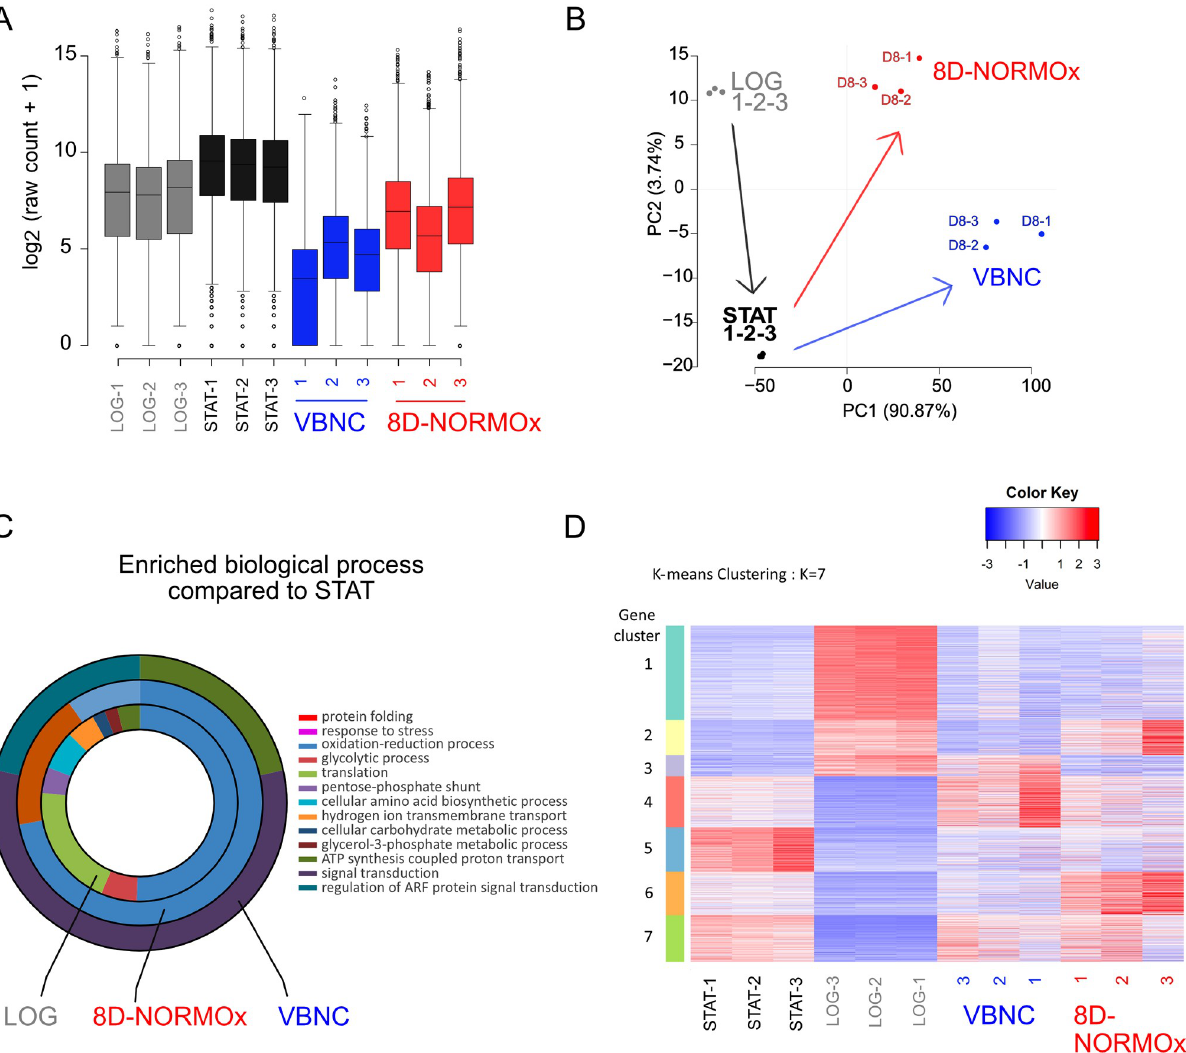
Fig 9. The global transcription is decreased in VBNC but remains specific. A . Transcriptional level of all conditions relative to that of S . cerevisiae spiked in each sample showed a significant decrease in VBNC compared to other conditions B . PCA analysis of the global transcriptomic data (wo_spikes) suggested that logarithmic cells (LOG) evolve to STAT which evolve to VBNC or 8D-NORMOx C . GO enrichment analysis of upregulated transcript (wo_spikes) compared to STAT. The major enriched biological processes were signal transduction, ATP synthesis coupled proton transport in VBNC and protein folding, oxidation reduction process and response to stress in 8D-NORMOx. D . Heat map of the gene expression revealed the presence of 7 clusters displaying different expression patterns for all conditions. The color key represents normalized transformed counts. Biological triplicates were used for